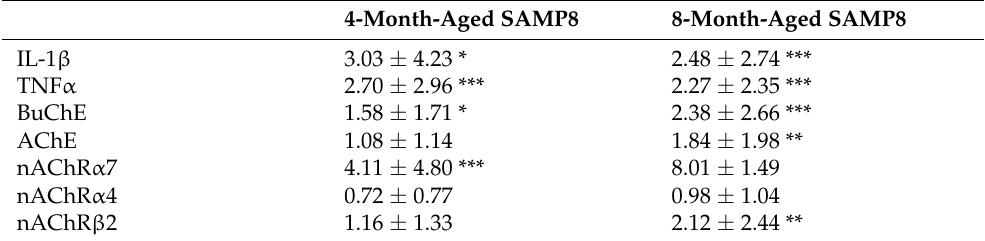
Table 7. Gene expression (2 − ∆∆ Ct ) of IL-1 β , TNF α , BuChE, AChE, nAChR α 7, nAChR α 4 and nAChR β 2 in the hippocampus of 4- and 8-month SAMP8 mice in relation to the composite brain samples from the same